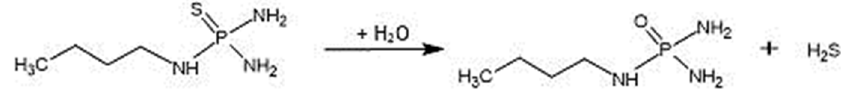
Figure 1. Conversion of NBPT to